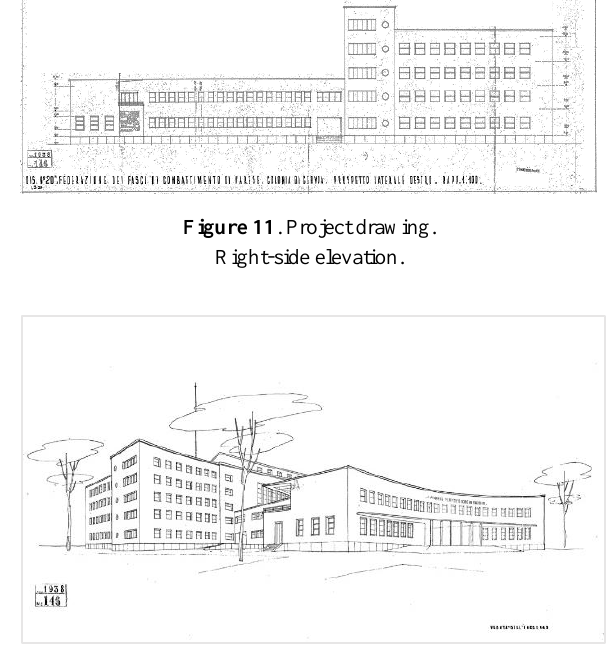
Figure 12 . Project drawing. Overall view. Entrance.